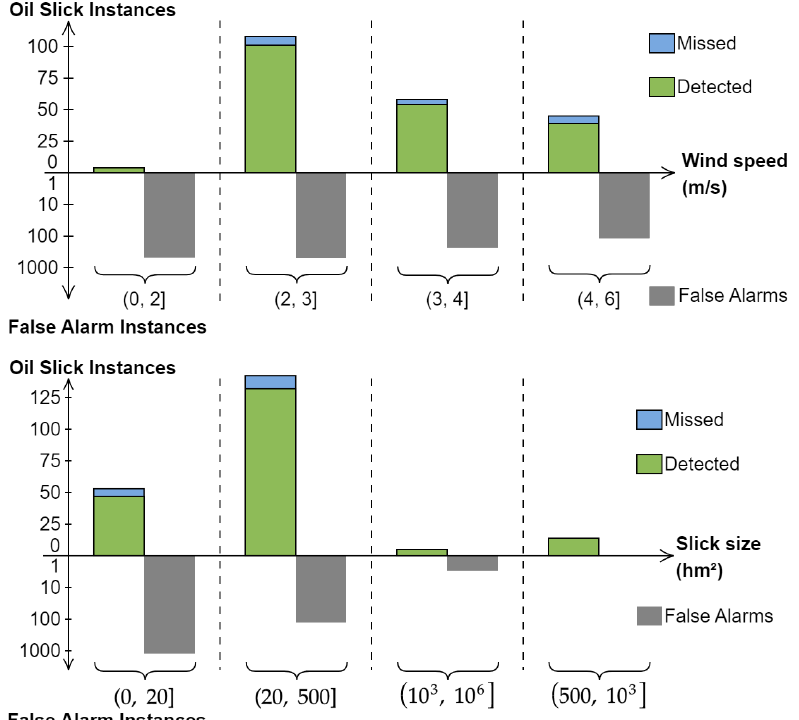
Figure 17. Detection performance of Fuse-FC-DenseNet as a function of wind speed (m/s) and ground truth size (hm²), early fusion case.